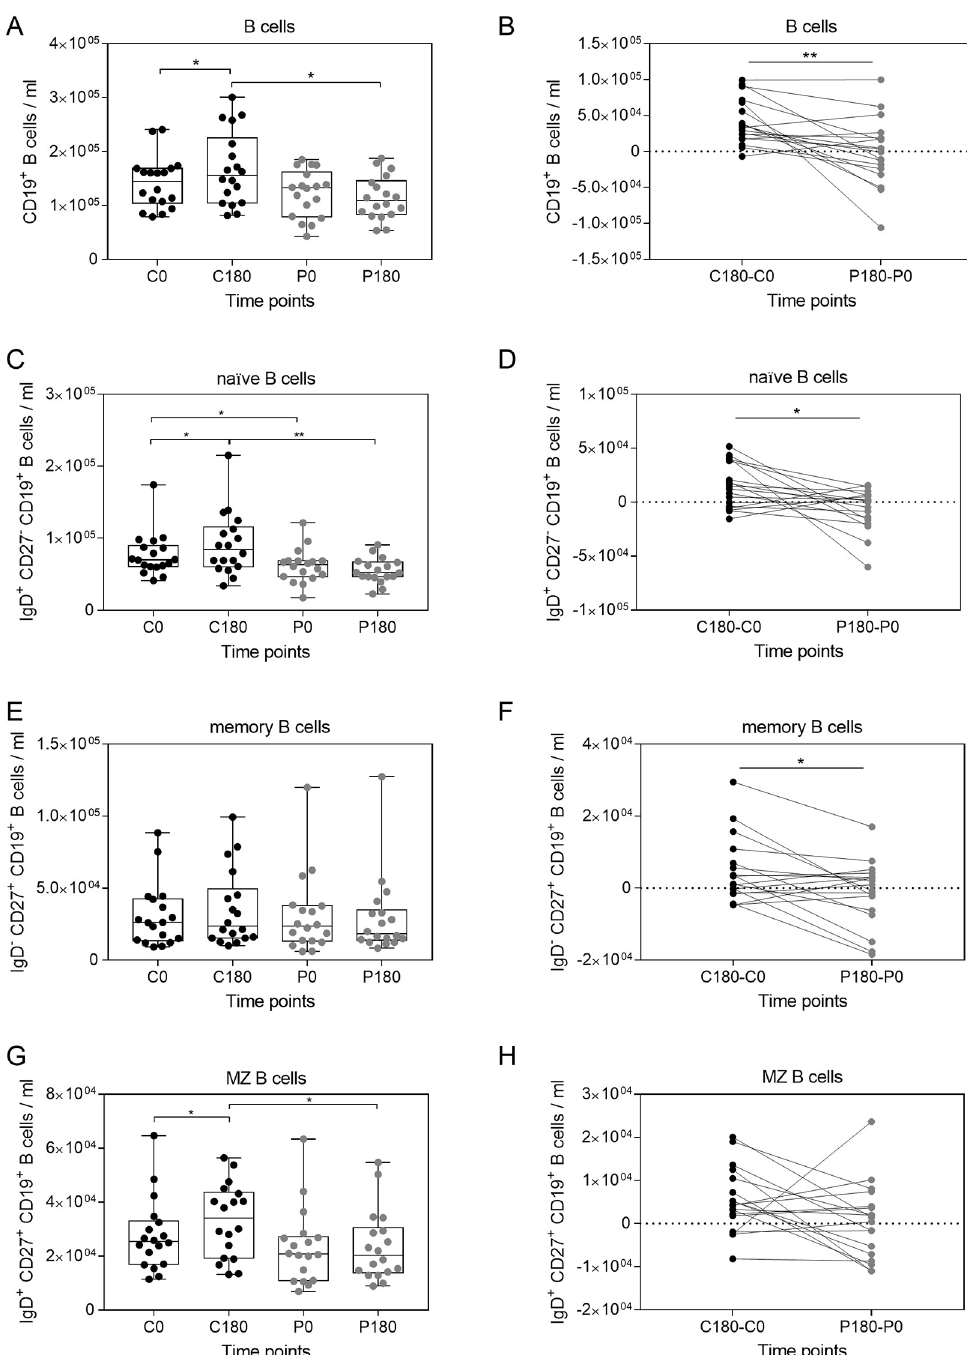
Fig 6. Circulating B cell populations can be influenced by gravitational stress. B cells were identified according to CD19 expression among the CD45 + lymphocyte population by flow cytometry (S7 Fig). Na ï ve (C), memory (E), and marginal zone like (MZ) B cells (G) were identified and quantified according to IgD and CD27 expression. The differences between the control period and the parabolic flight period are shown for na ï ve B cells (B) memory B cells (D) and MZ B cells (F). Asterisks indicate p-values ( ��� p < 0.01; �� p < 0.01; � p < 0.05) of the statistical